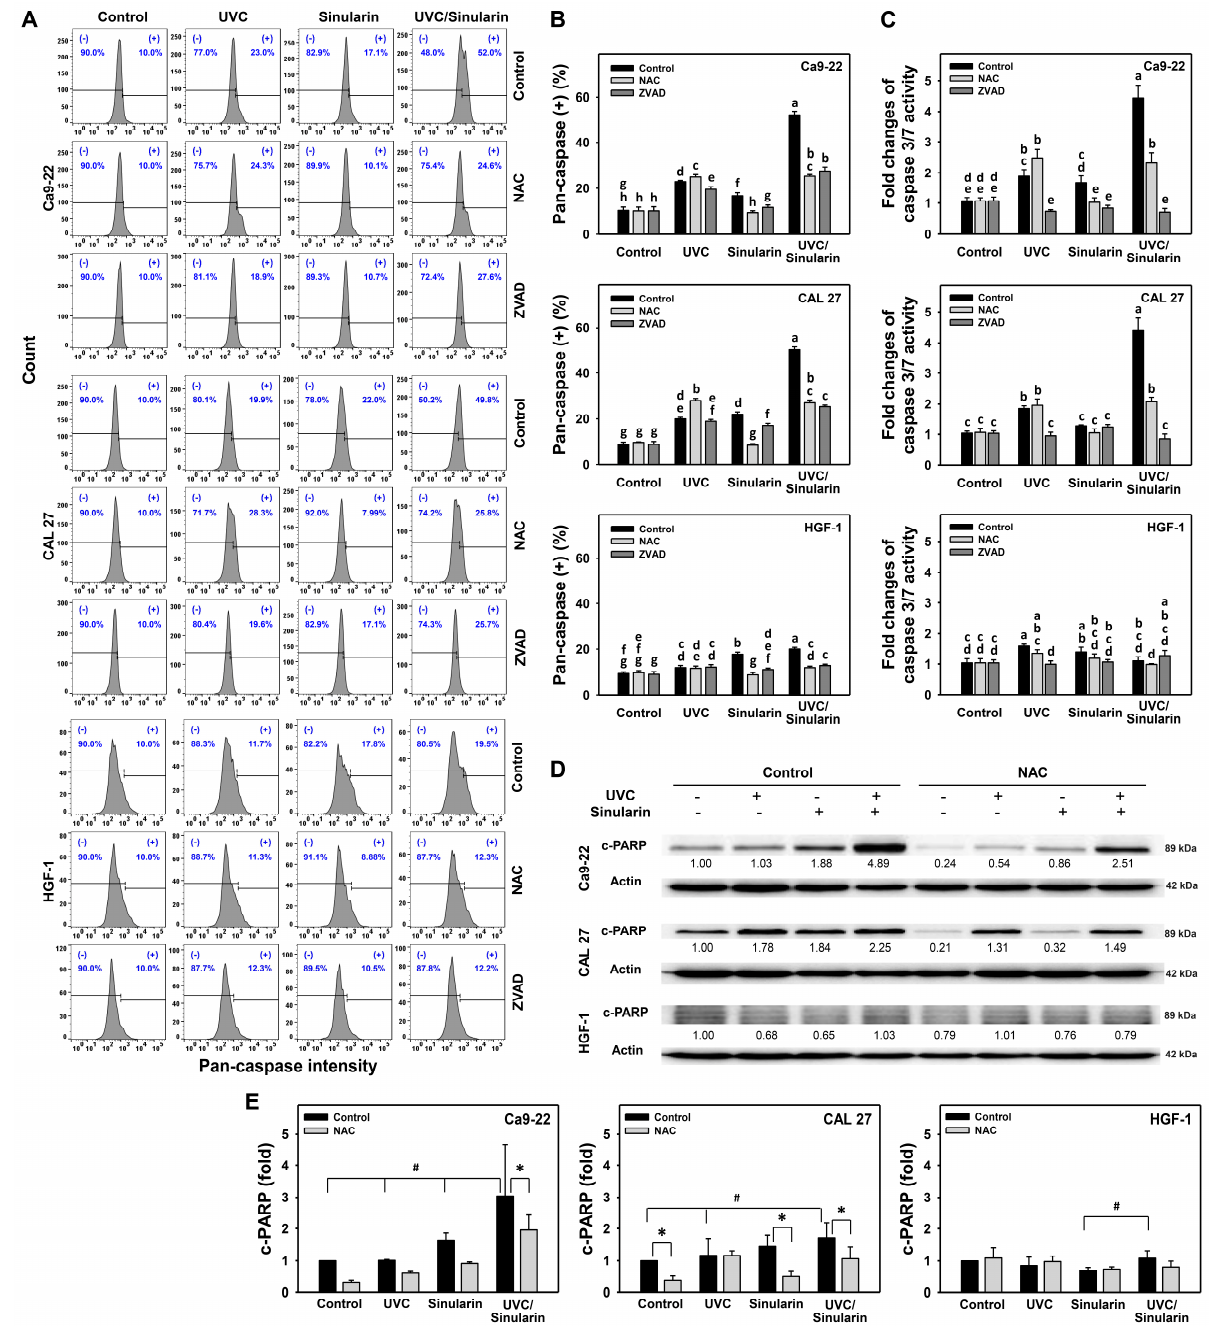
Figure 4. Pan-caspase flow cytometry, Cas 3/7 luminescence assay, and apoptosis Western blotting of the UVC and/or sinularin treatments. Following the NAC (5 mM for 1 h) or ZVAD preincubations (100 μM for 2 h) or not, the cells were arranged into four kinds of treatments: the control (0.1% DMSO in medium), UVC, sinularin, and UVC/sinularin for 48 h. The UVC and/or sinularin conditions were 12 J/m 2 , 2 μM and 10 J/m 2 , 3 μM for oral cancer cells (Ca9-22, CAL 27), and 12 J/m 2 , 3 μM for normal cells (HGF-1) for 48 h, respectively. ( A , B ) Pattern and quantifications for the pan-caspase analysis: (+) indicates pan-caspase-positive (%). ( C ) Luminescent assay for caspase 3/7 activity. For multi-comparisons, the treatments marked without repeated characters (a to h) differ significantly ( p < 0.05). The data were plotted as the mean ± SD ( n = 3). ( D , E ) c-PARP expression and statistical analysis for apoptosis detection. The Student t -test analyzed the significance. # was compared between UVC/sinularin and other treatments in the absence of NAC ( p < 0.05). * was the comparison between the pair treatment in the presence and absence of NAC ( p < 0.05).